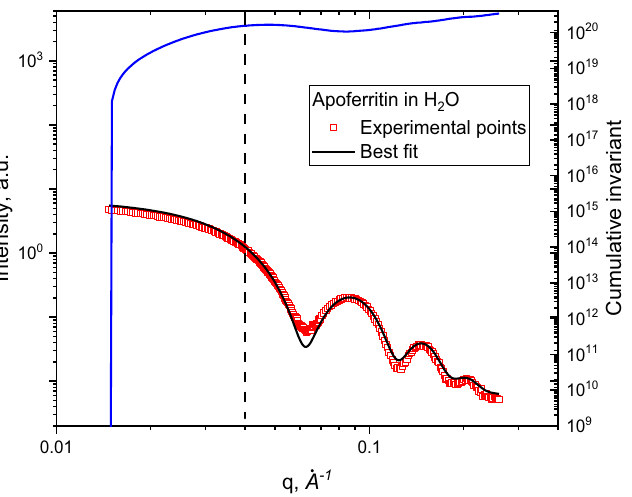
Figure 8. Small-angle X-ray scattering curves of apoferritin. Red squares correspond to experimental points, the black line corresponds to the best fit and the blue line corresponds to the cumulative